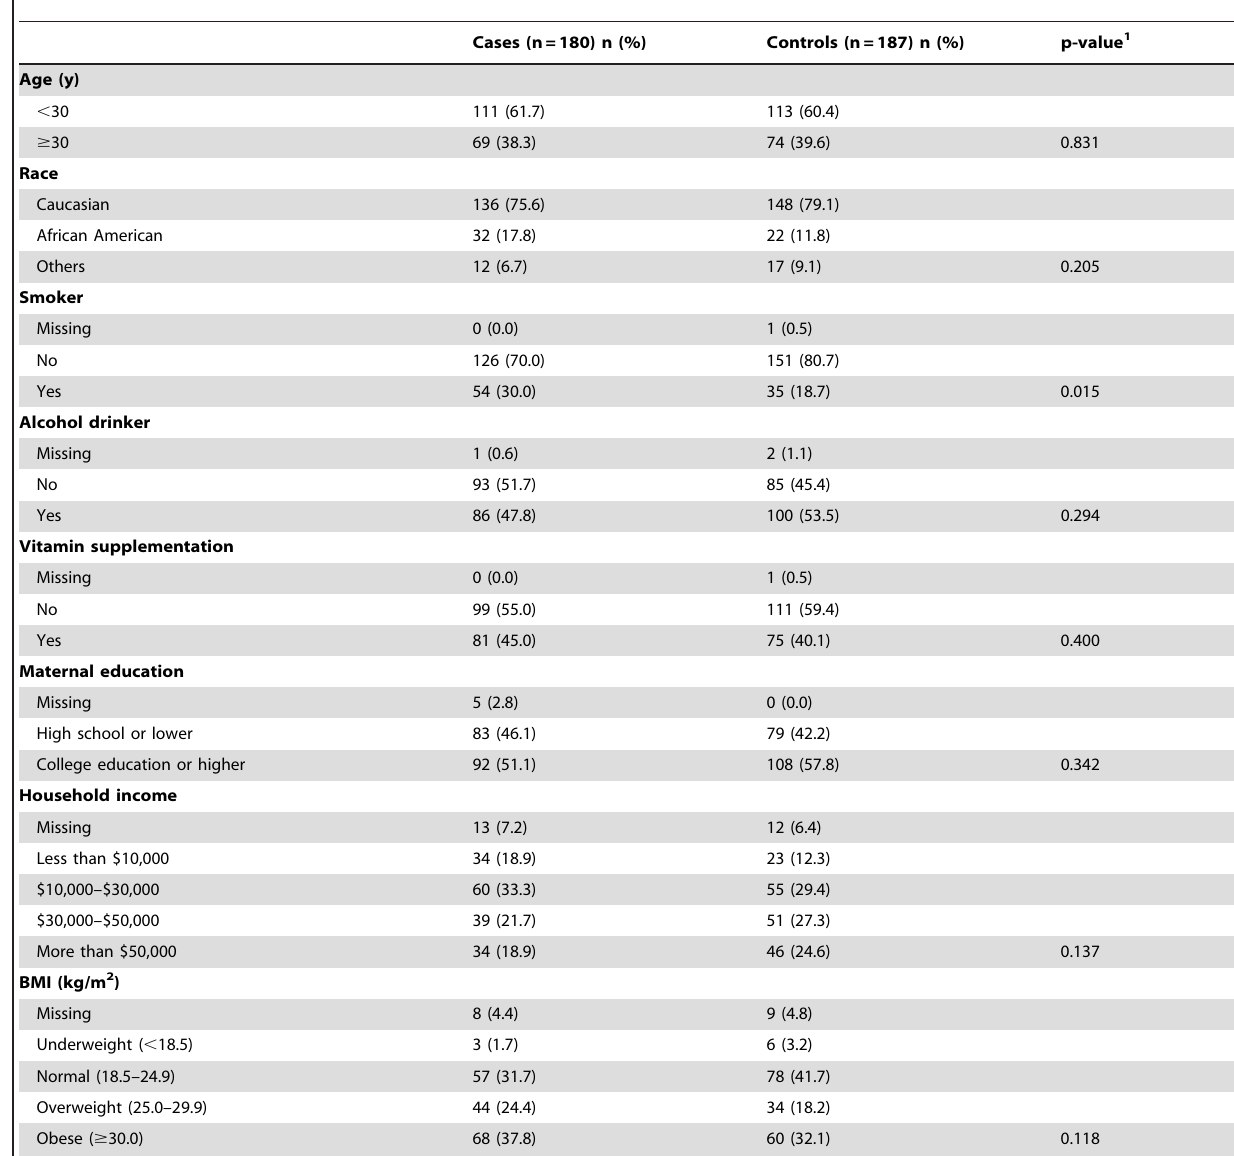
Table 1. Selected characteristics of cases and